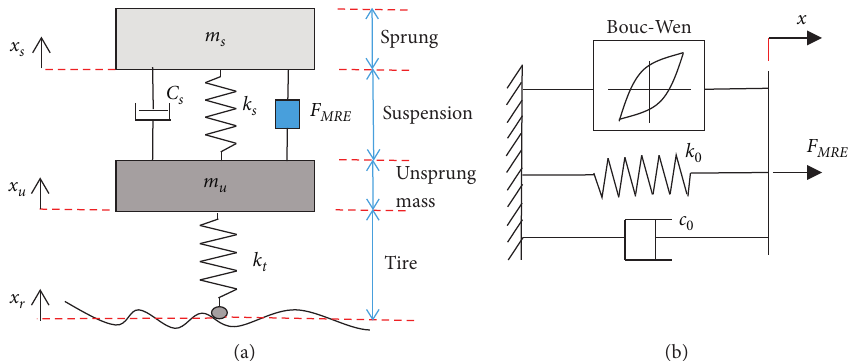
Figure 7: The novel suspension system using MRE-based absorber: (a) the suspension system and (b) the isolator